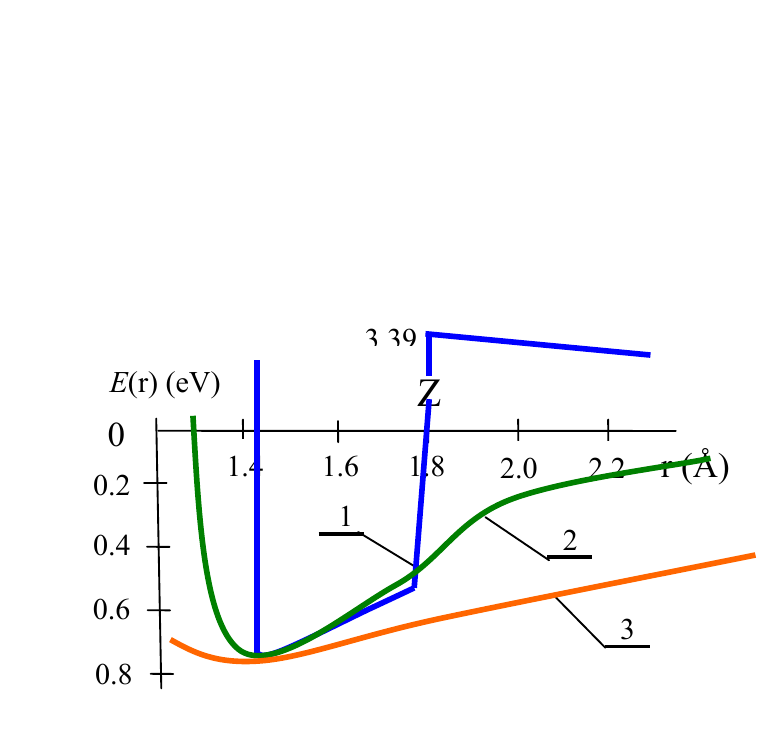
Figure 8 – Interaction potential in the diatomic sodium molecule obtained using: 1 - formula (25); 2 - Lennard-Jones formula; 3 - Morse